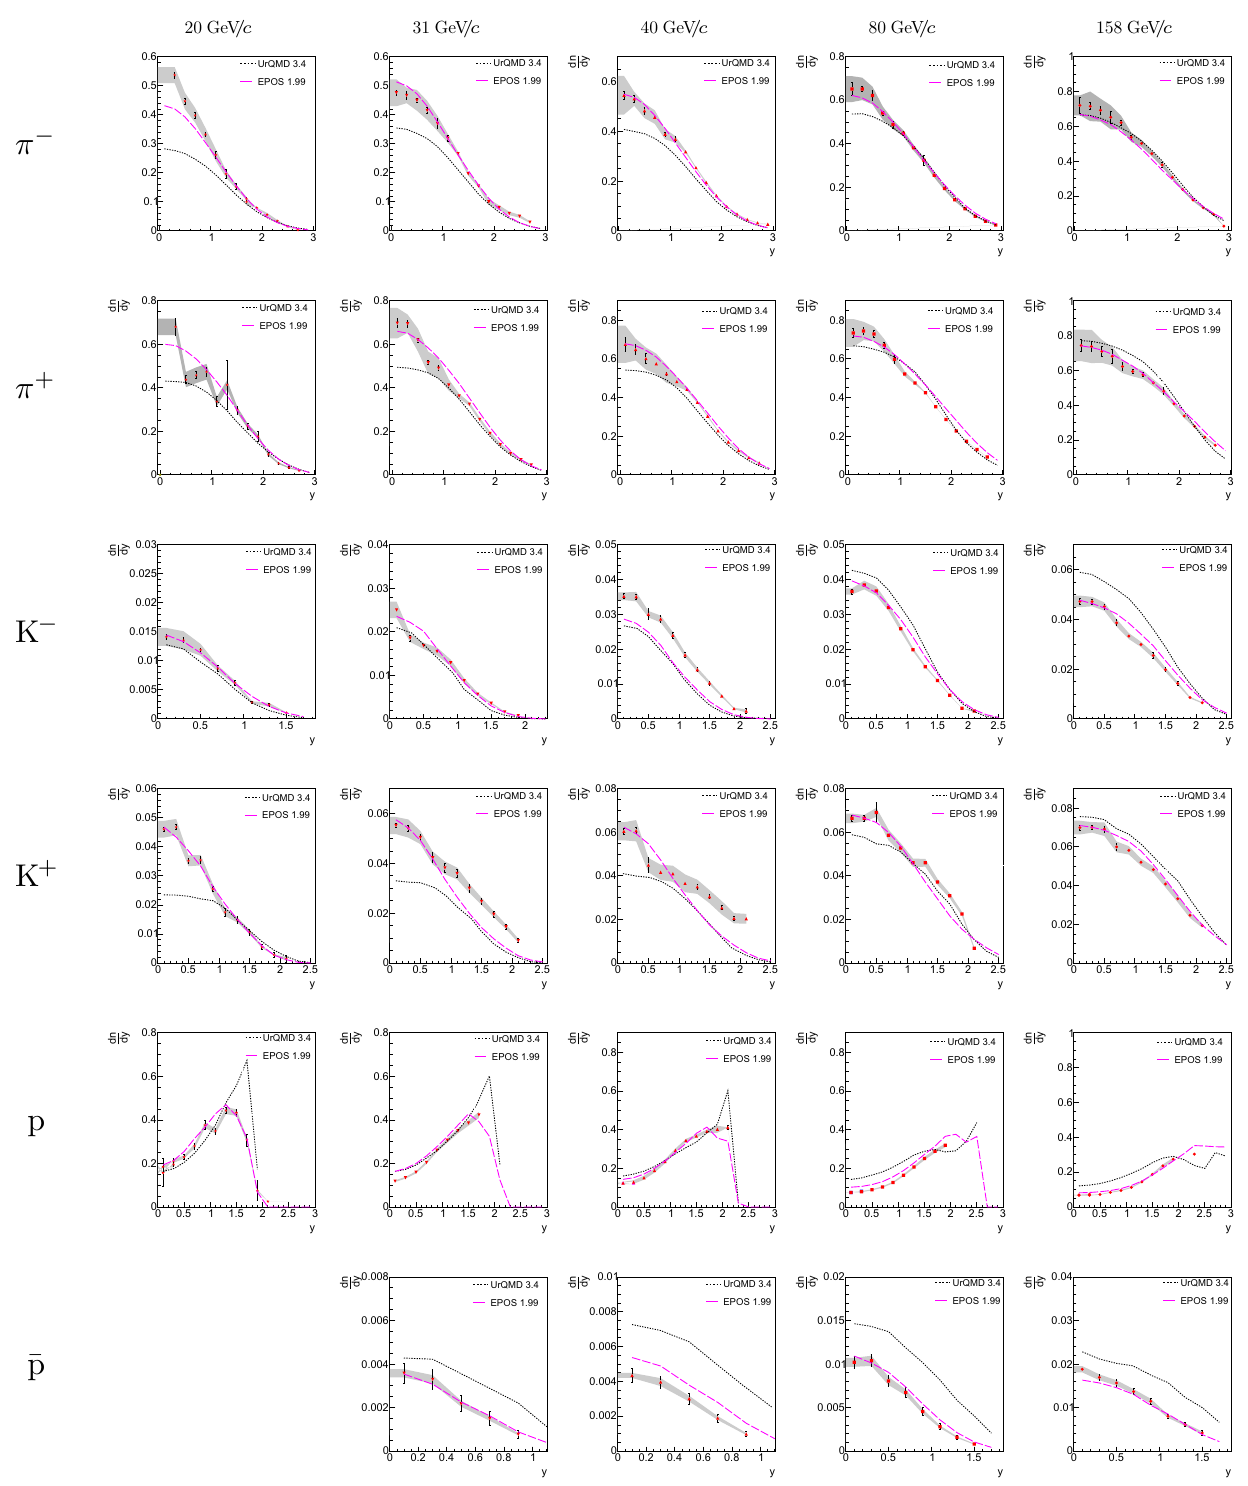
Fig. 43 Rapidity distribution of π − , π + , K − , K + , p and ¯ p produced in inelastic p + p interactions at 20, 31, 40, 80 and 158 GeV / c compared with predictions of the EPOS [21] (dashed lines) and U r QMD [27,28] (dotted lines)